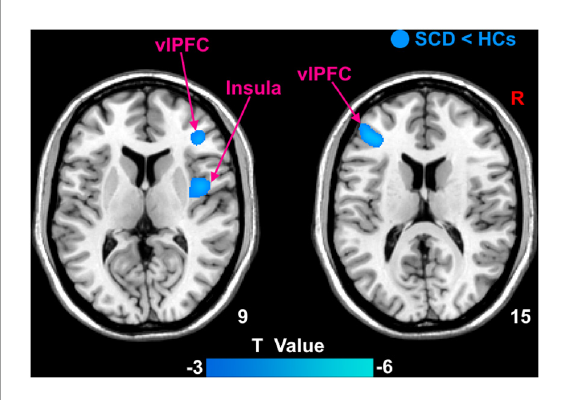
FIGURE3 The GMV differences between subjective cognitive decline (SCD) patients and healthy controls (HCs). Brain regions marked by cool color represent significantly decreased GMV in patiens with SCDs relative to